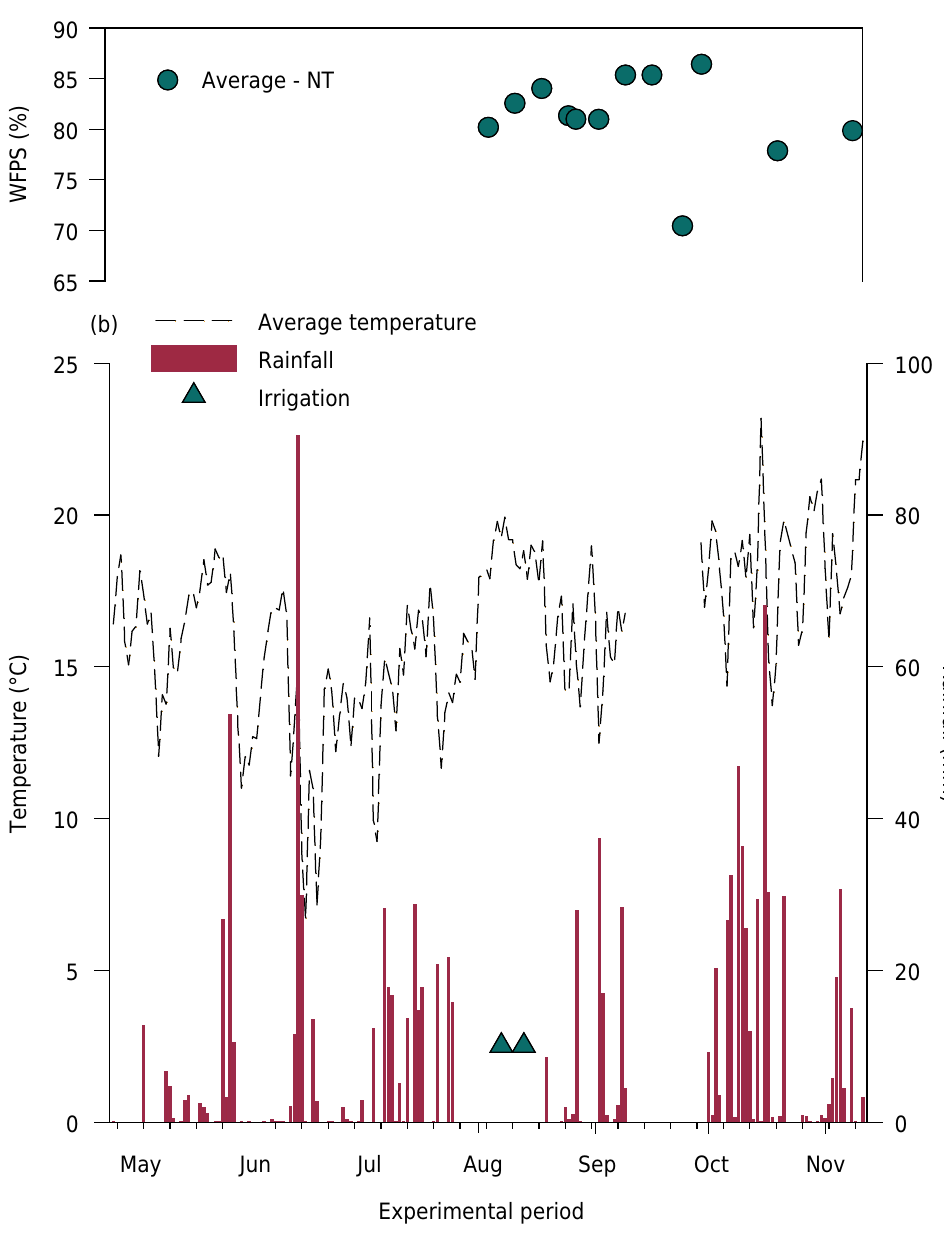
Figure 1. Water-filled pore space (a), average air temperature (b), rainfall (b), and irrigation (b) values throughout the onion growth cycle. No data were available from September 10-28. Transplanting occurred on August